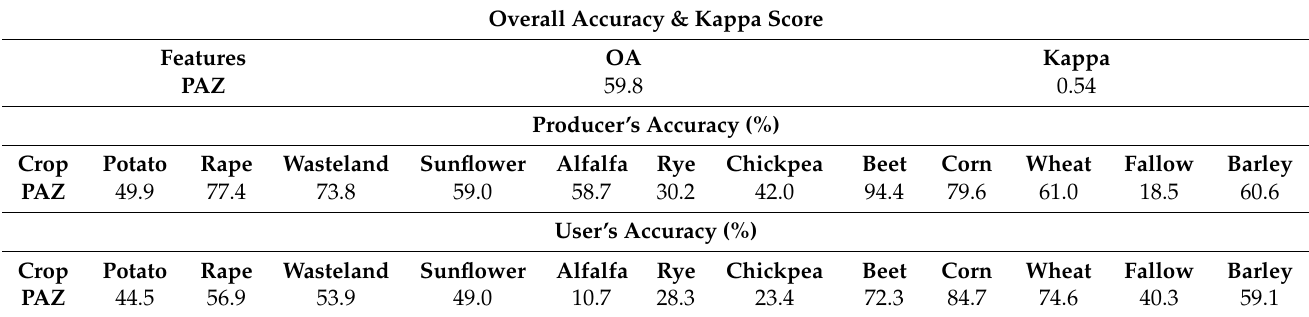
Table 3. Classification scores at pixel level with eight PAZ images. Overall Accuracy & Kappa